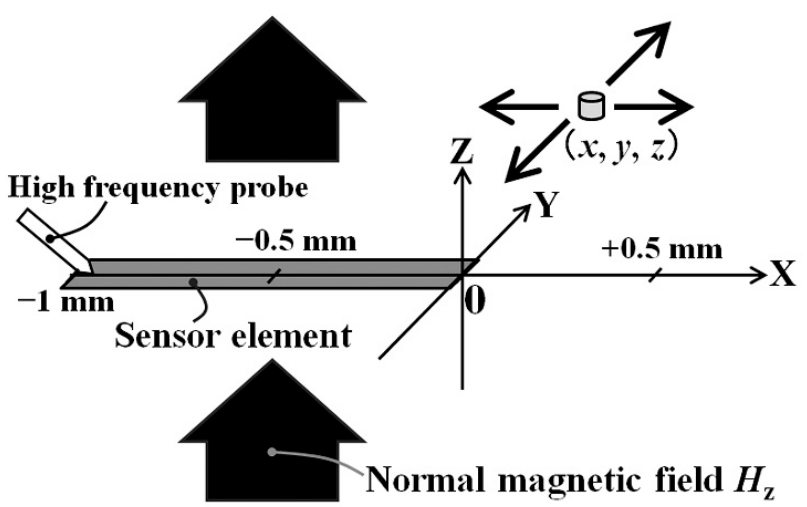
Figure 23. Schematic illustration of the measurement system of magnetic small particle [21].